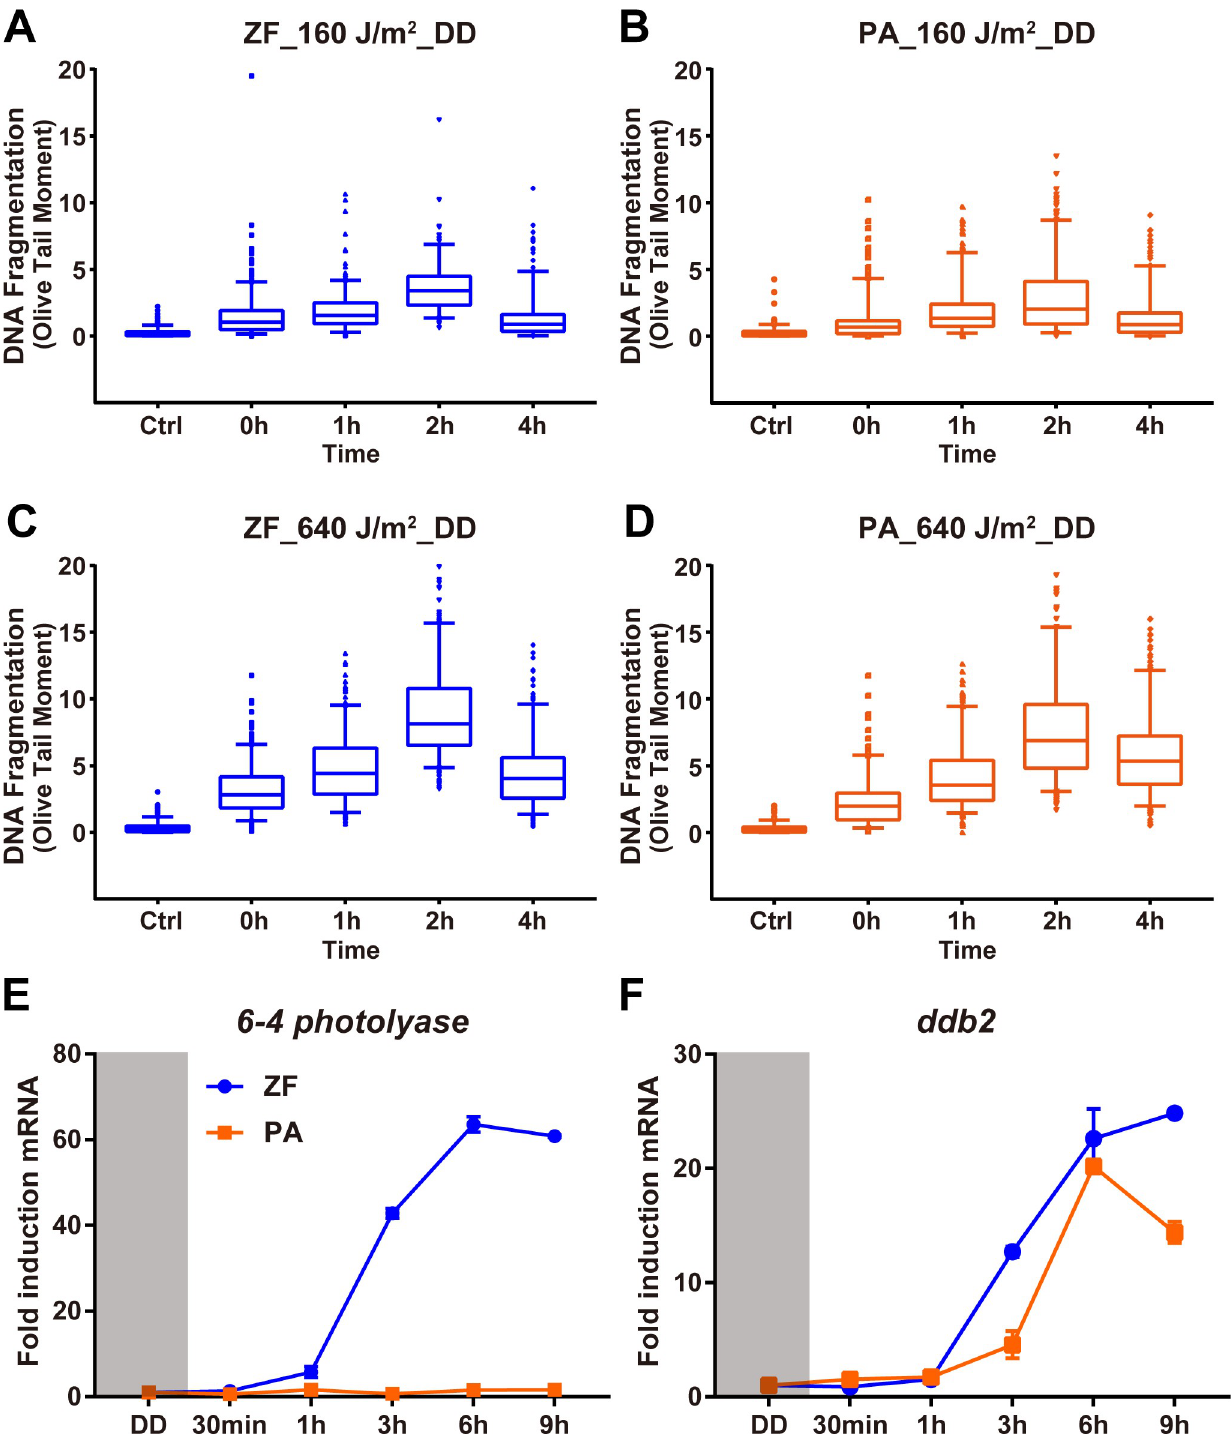
Fig 1. DNA repair of UV induced damage in constant darkness. (A-D) Comet assay results from zebrafish AB-9 (A, C) and P . andruzzii CF-1 (B, D) cells. Data for levels of DNA fragmentation (Olive Tail Moment) is represented as box plots. The median is given as the central line, with 25th and 75th percentiles as frames. Whiskers indicate the 10th and 90th percentiles. Single outliers are illustrated as dots. Times after UV treatment are indicated on the x axes. (n = 3 experimental units, N = 300 observational units per time point). For each panel, Kruskal-Wallis test followed by Dunn’s multiple comparisons test results are reported in S1 Table. (E,F) Visible light-induced expression of ddb2 in zebrafish and P . andruzzii cells. qRT-PCR analysis of 6– 4 photolyase and ddb2 mRNA expression in zebrafish PAC-2 (ZF, blue traces) and P . andruzzii EPA (PA, orange traces) cells during 9 hours of blue light